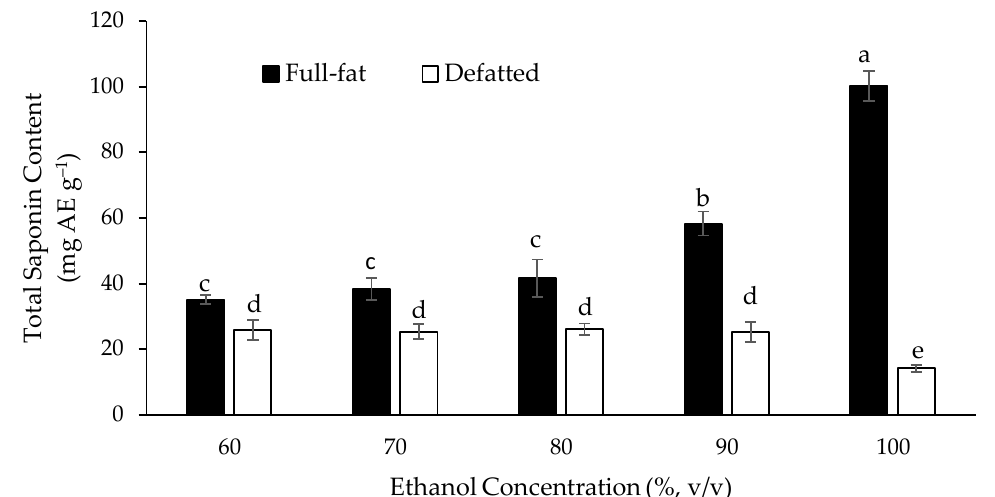
Figure 2. Effect of the ethanol concentration, in the extraction solvent used for microwave-assisted extraction (MAE), on the measured total saponin content (TSC) of the full-fat and defatted Gac seed kernel powders. The values are the means of three replicates for each extraction and columns not sharing the same superscript letter are significantly different at p < 0.05.